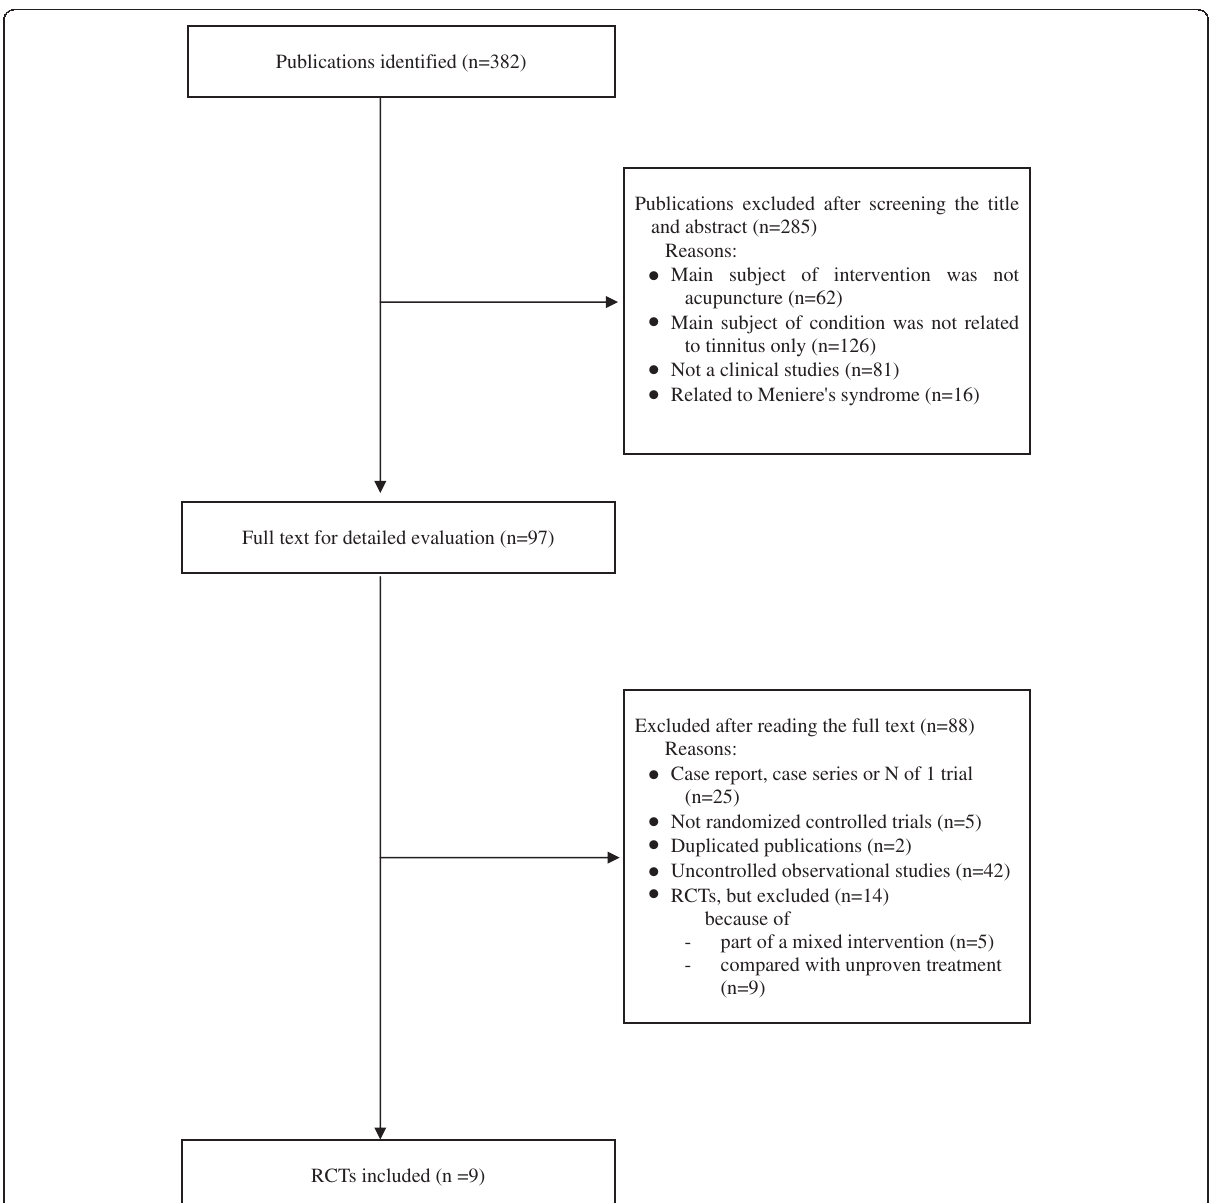
Figure 1 Flowchart of the trial selection process. RCT: randomized clinical trial; CCT: non-randomized controlled clinical trial; UCT: uncontrolled clinical